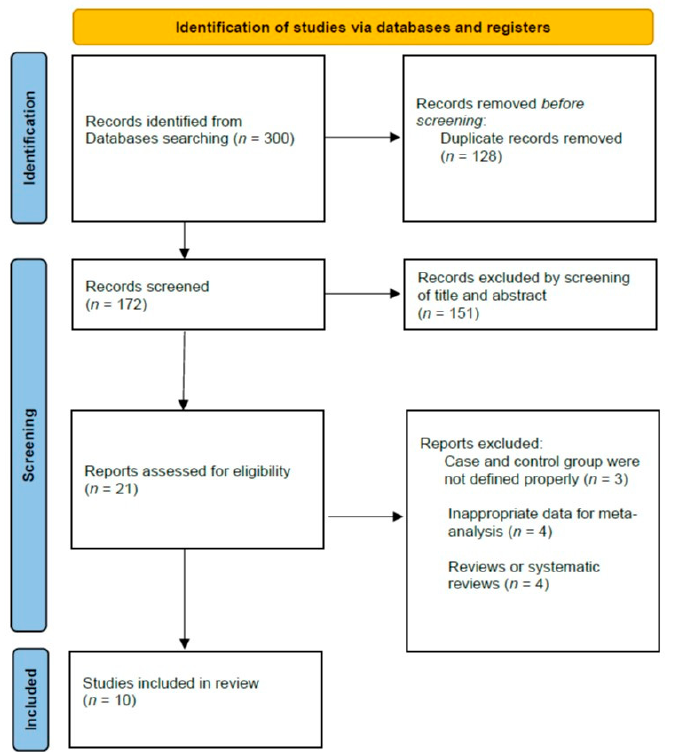
Figure 1. Flow chart for literature identification using the Preferred Reporting Items for Systematic Reviews and Meta-Analyses (PRISMA) guidelines.